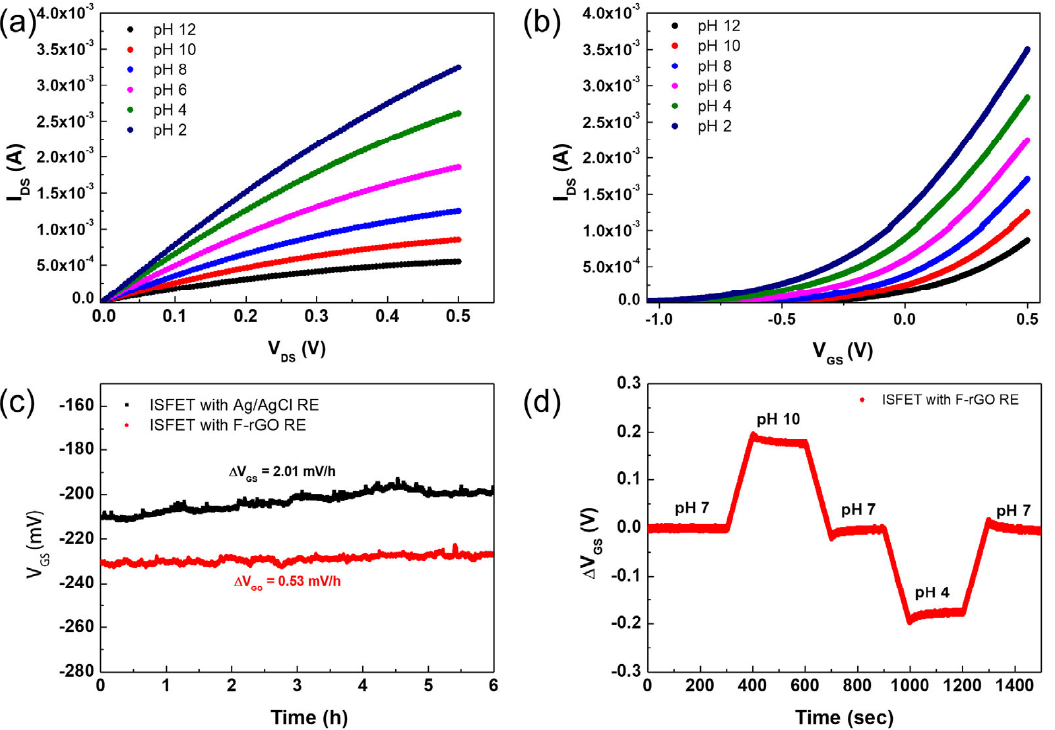
Figure 4. ( a ) I DS − V DS , ( b ) I DS − V GS , ( c ) long ‐ term stability, and ( d ) hysteresis characteristics of ITO − ISFET with F − rGO RE in a pH buffer solution.